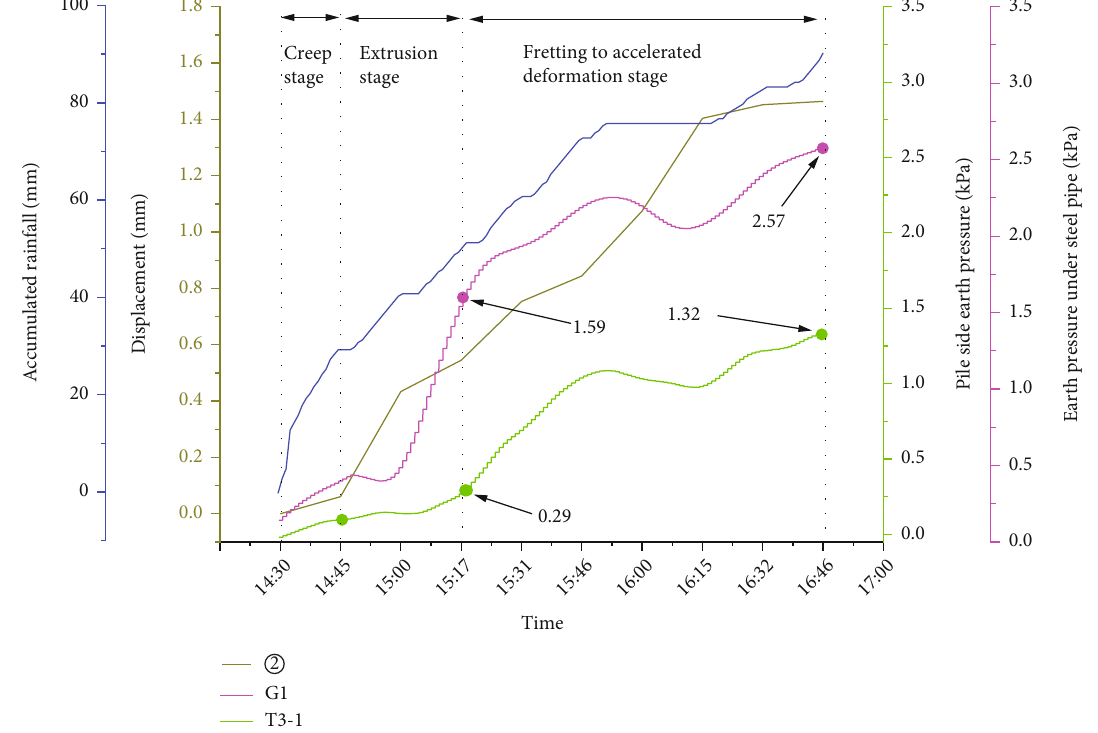
Figure 10: The correlation curve of slope and protective structure under